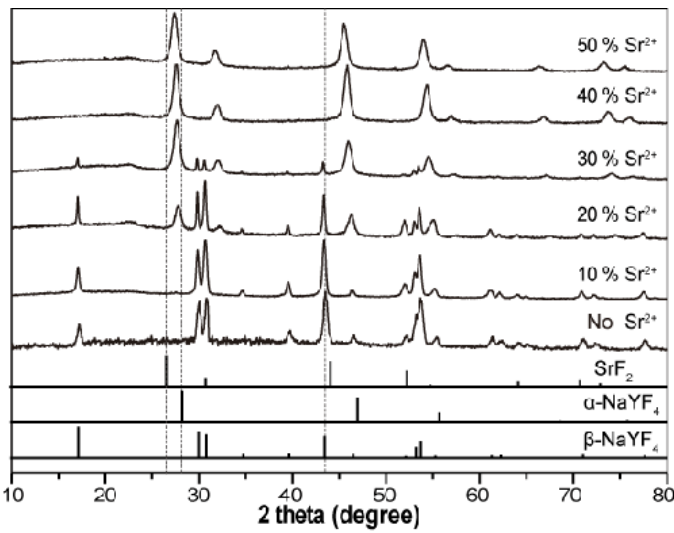
Figure 2. X-ray diffraction (XRD) patterns of the NaYF :Yb/Er (18/2 mol %) 4 nanoparticles obtained in the presence of different amount of Sr 2+ dopant ions. The bottom line spectra are literature data for cubic phase SrF (JCPDS file number 06-0262 [40]), 2 cubic phase NaYF (JCPDS file number 77-2042 [41]) and hexagonal phase NaYF 4 4 (JCPDS file number 16-0334 [39]),